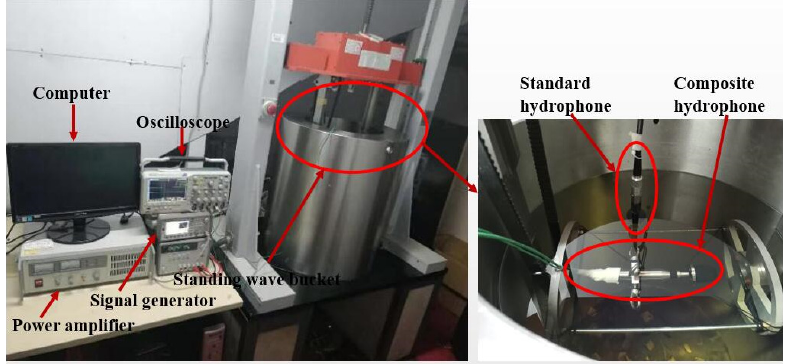
Figure 16. The composite hydrophone test system.